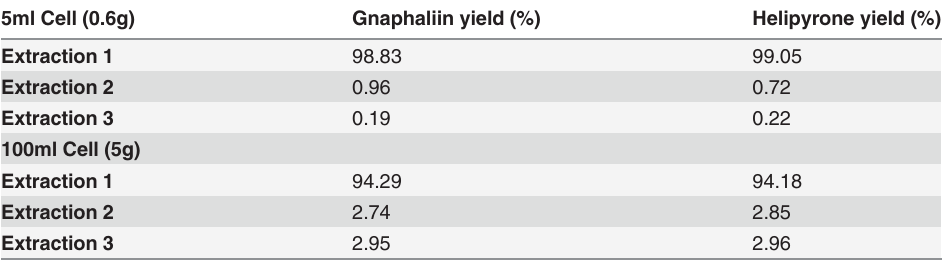
Table 1. Gnaphaliin and Helipyrone yield in successive extractions with the optimized method and in